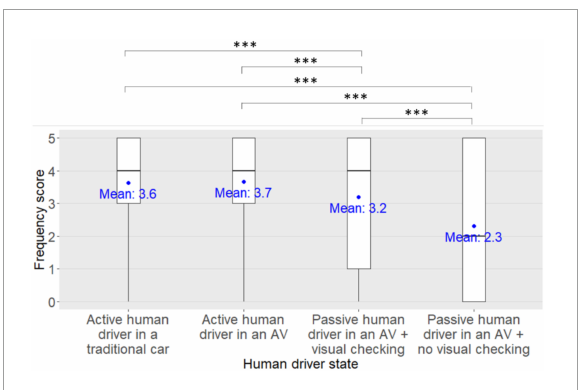
FIGURE3 Main effect of the human driver state on the pedestrians’ frequency scores for seeking eye contact with the driver of the approaching car in order to express their willingness to cross to the human driver. ***: pFDR <